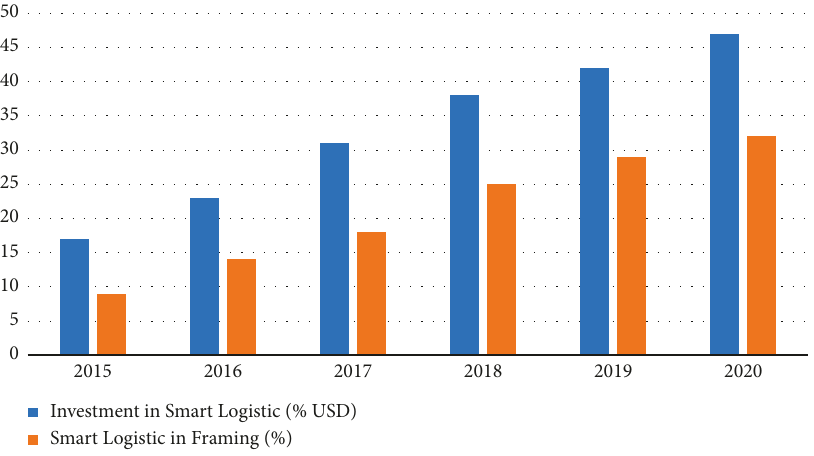
Figure 4: Statistic regarding smart